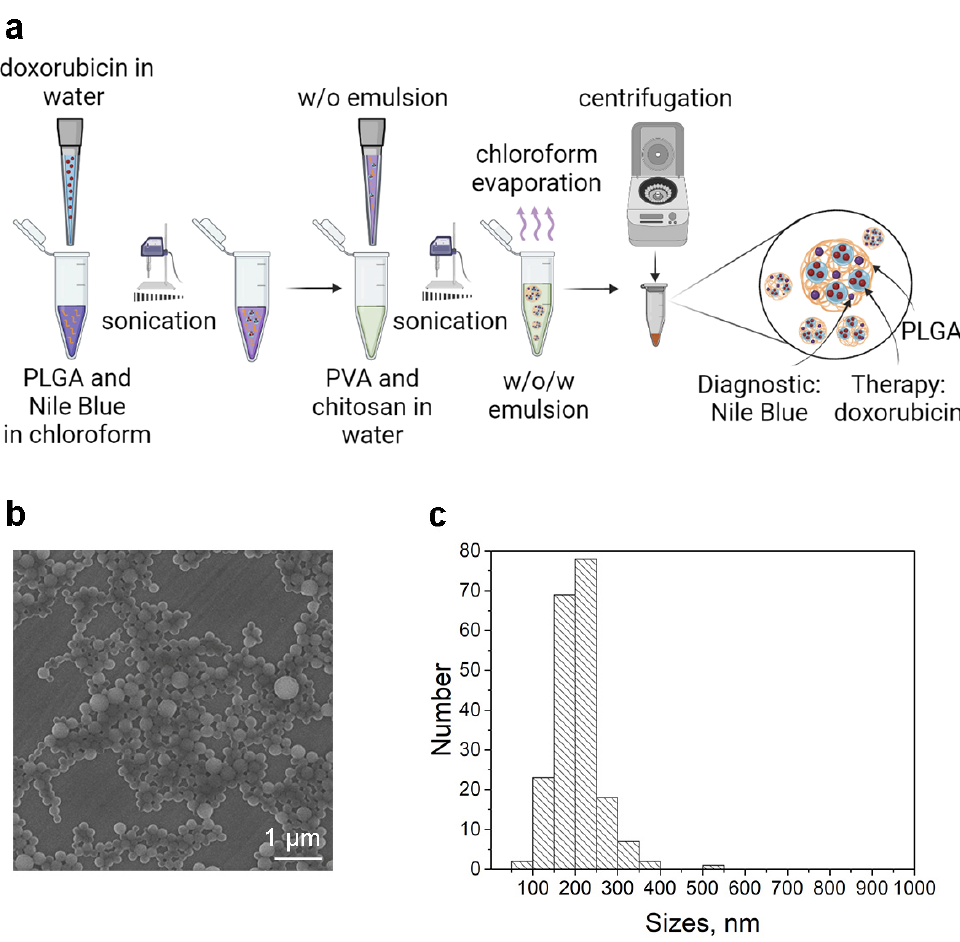
Figure 2. Synthesis and characterization of PLGA nanoparticles for targeted drug delivery. ( a ) Scheme of the synthesis. ( b ) Scanning electron microscopy of PLGA nanoparticles. ( c ) Physical size distribution obtained through SEM image processing.